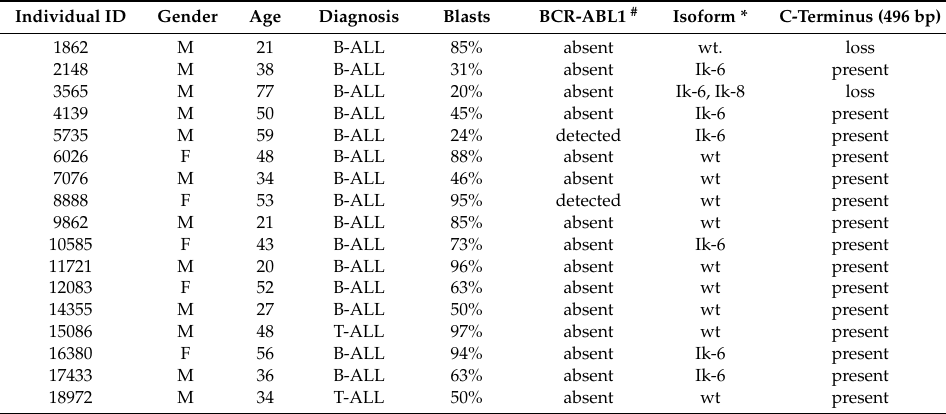
Figure 2. Sequencing confirmation and amino acid translation of the Ik-8 and Ik-6 PCR products. Sanger sequencing was performed on cloned Ik-8 and Ik-6 isoforms in a clinical sample (case 3565, Table 1) and lymphoblastic cell line (SUP-B15), respectively. The colored numbers below the sequencing traces were predicted codons and corresponding amino acids of IKZF1 (NC_000007.14). Table 1. Screening of IKZF1 isoforms expressed in ALL samples.